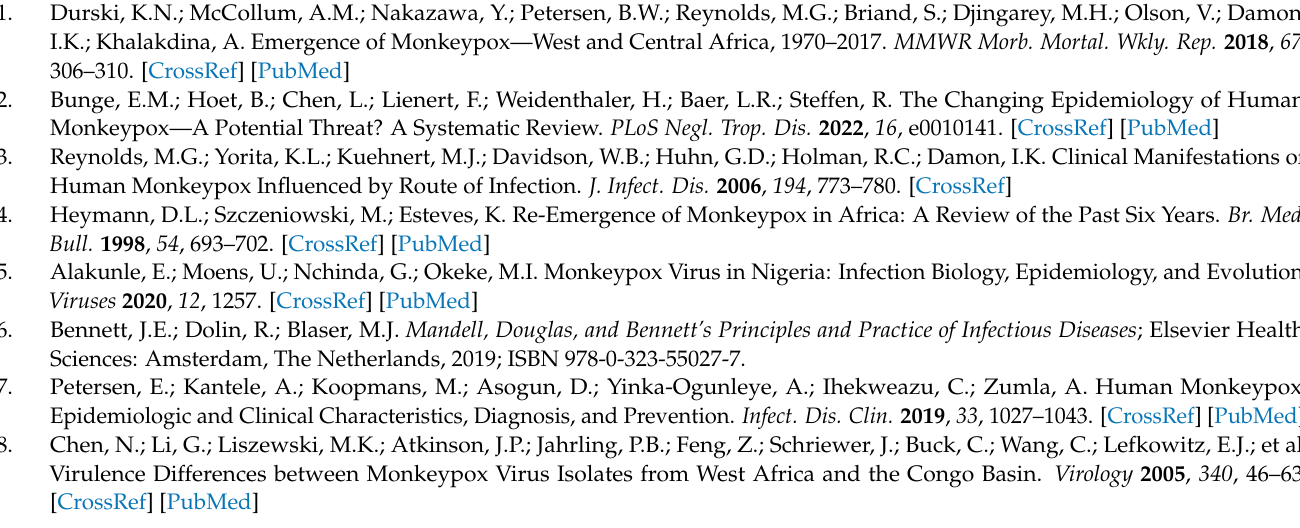
Figure S2; Target-reference ligand interaction; Figure S3, First and last pose of reference molecule; Figure S4; RMSD and RMSF plots of reference compound in complex with the target protein; Figure S5; RMSF plots for protein docked with natural compounds; Figure S6; Ligand protein contacts of all the selected compounds after MD simulations; Figure S7; Protein-ligand contact mapping for reference ligand after MD simulation; Figure S8; PCA analysis of reference compound in complex with the target protein; Table S1; ADME analysis of all the selected